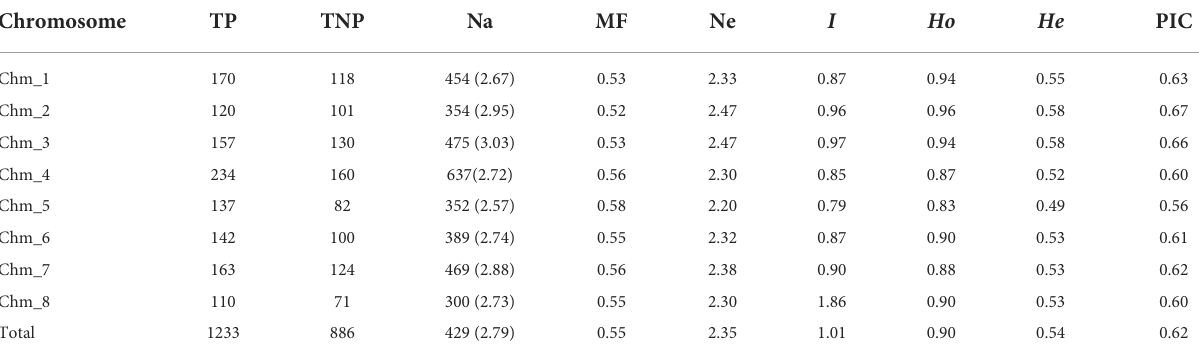
TABLE 3 ePCR-based marker statistics for 1233 chromosome-specific PIP primers assayed on four pomegranate genomes. Chromosome